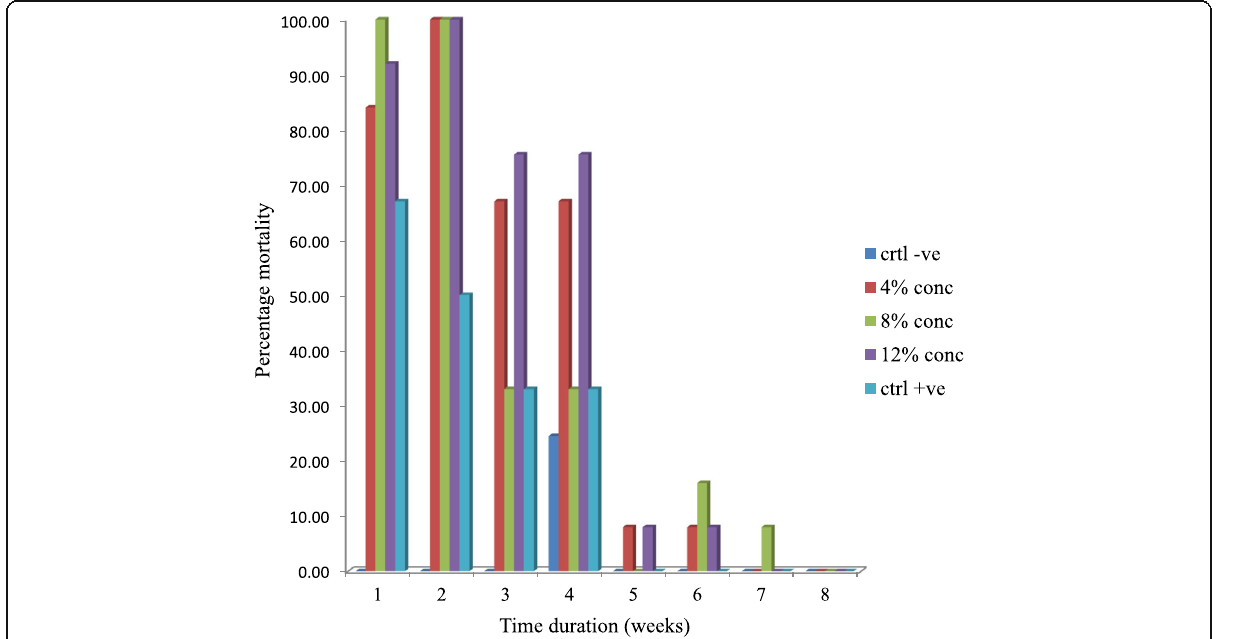
Fig. 2 Pesticidal effect of ethanolic extract of Dennettia